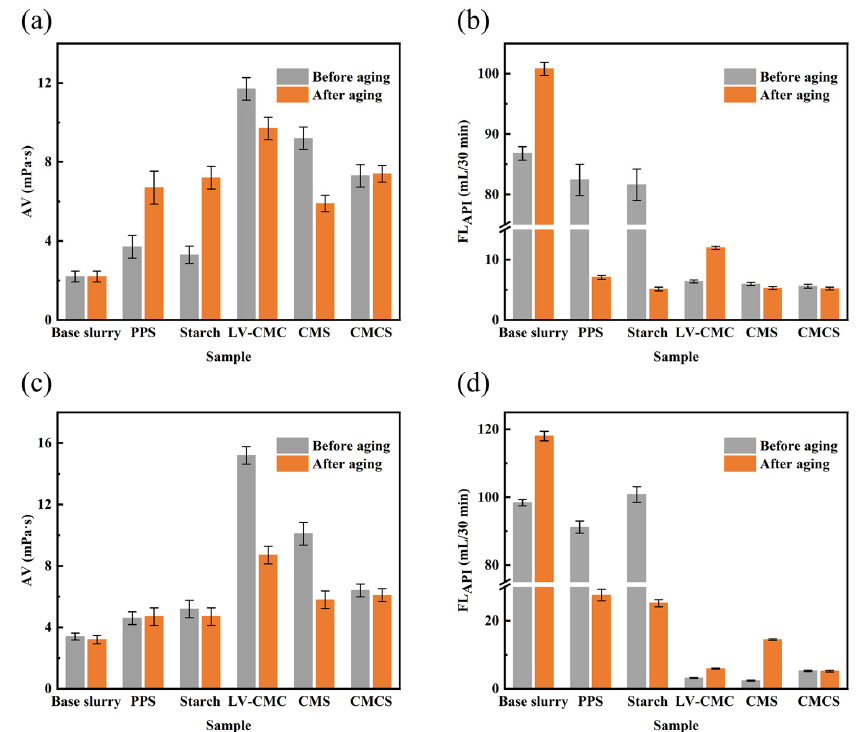
Figure 9. Performances of samples at the sample dosage of 1.50%. ( a ) Apparent viscosity in 4.00% NaCl brine base slurry; ( b ) Filtration loss value in 4.00% NaCl brine base slurry; ( c ) Apparent viscosity in saturated NaCl brine base slurry; ( d ) Filtration loss value in saturated NaCl brine base slurry.